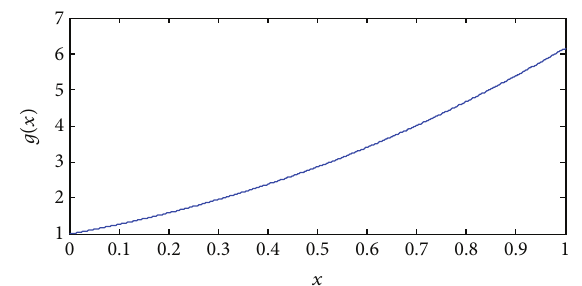
Figure 8: The 𝐿 2 -norm of 𝑈 for different 𝛾 ( 𝛾 ∈ [2.5, 10] , ‖𝑈‖ = (∫ 𝑇 |𝑈(𝑡)| 2 𝑑𝑡) 1/2 , 𝑇 = 2 0